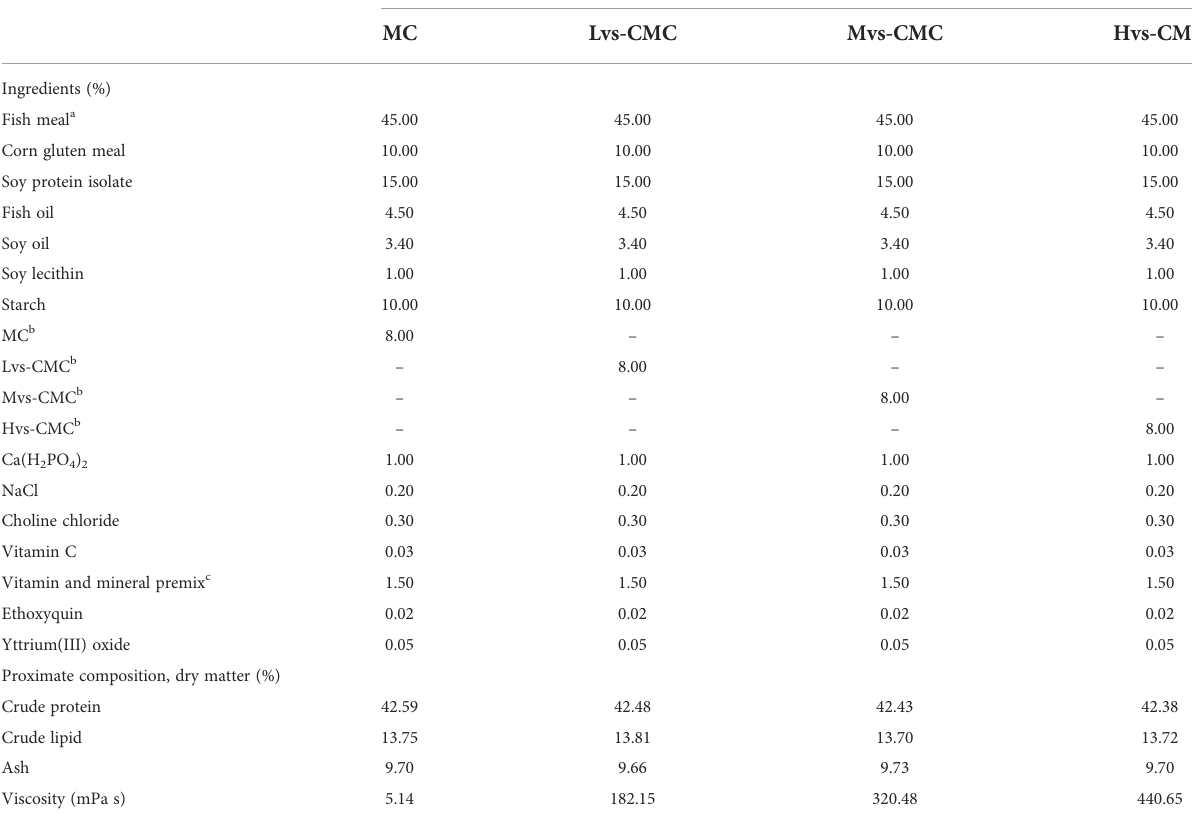
TABLE 1 Formulation and composition of the test